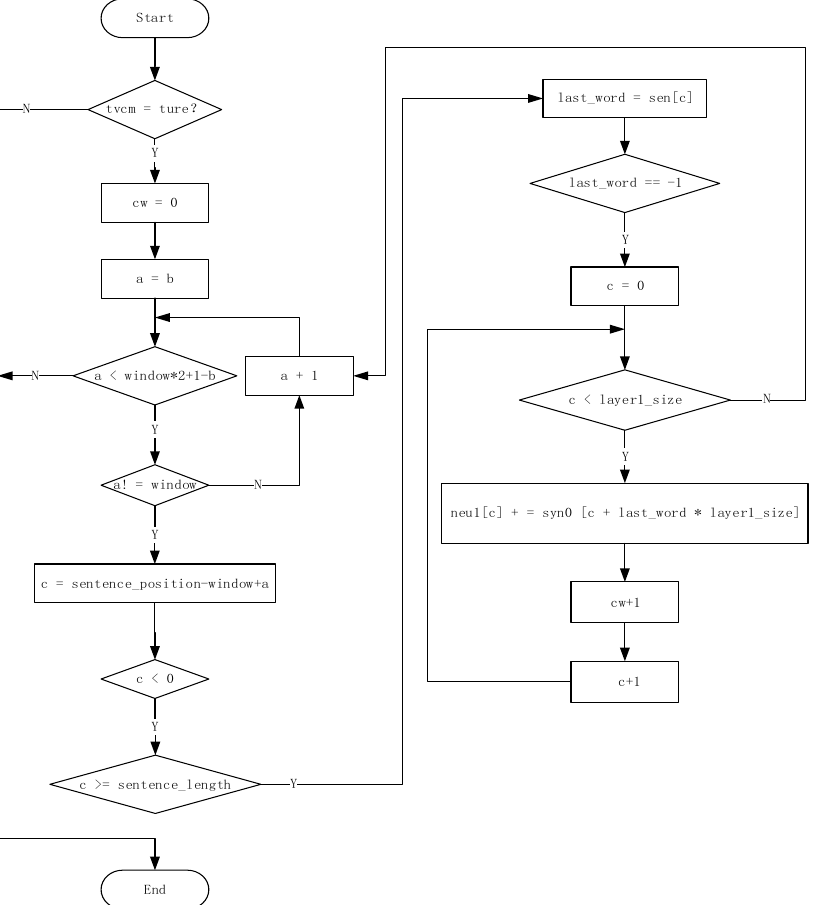
Figure 3. Part of the source code flow chart of the vectorization coding model.